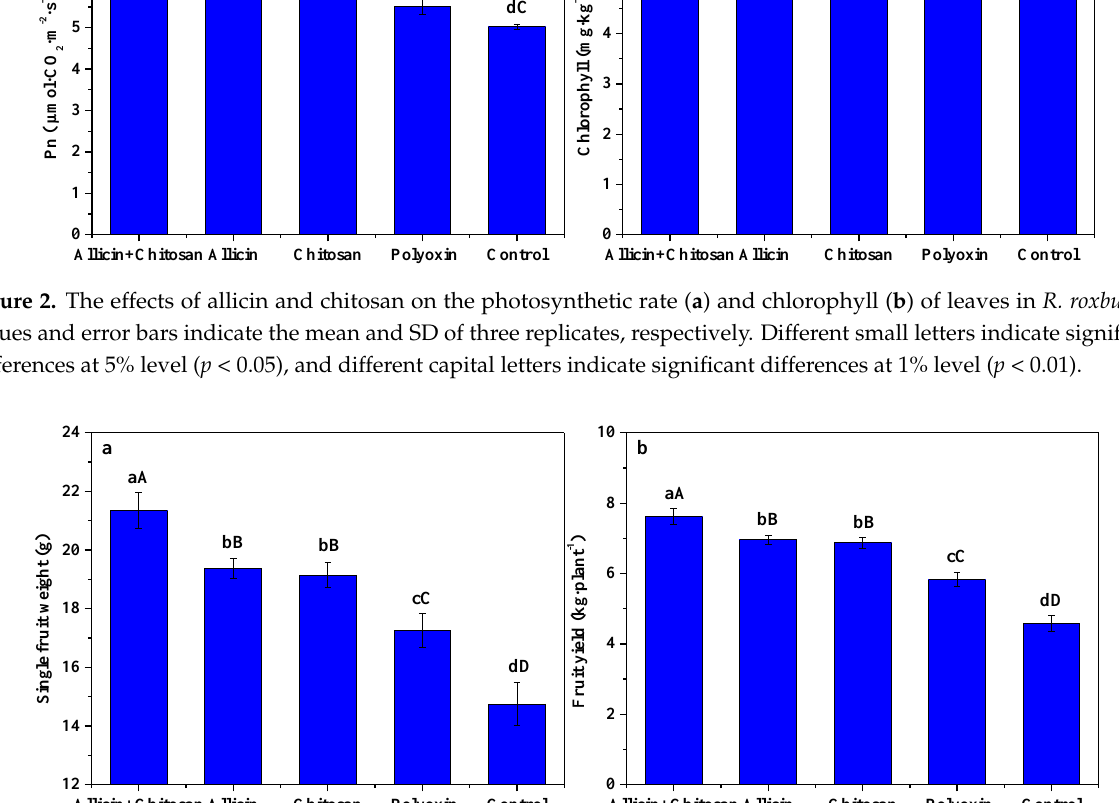
Table 4. The effects of allicin and chitosan on quality of R. roxburghii fruits.